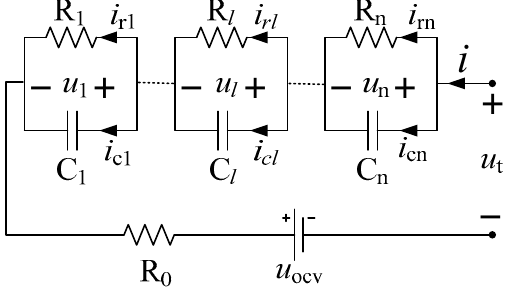
Figure 1. Equivalent circuit model for a Li-ion battery.